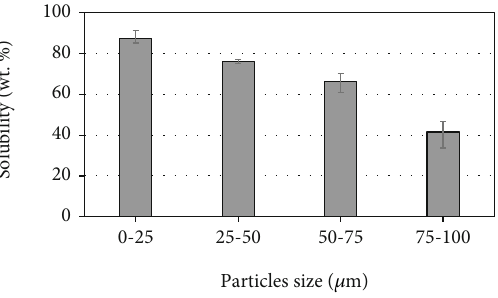
Figure 6: The e ff ect of particle size on hematite solubility in 10vol.% HCl.